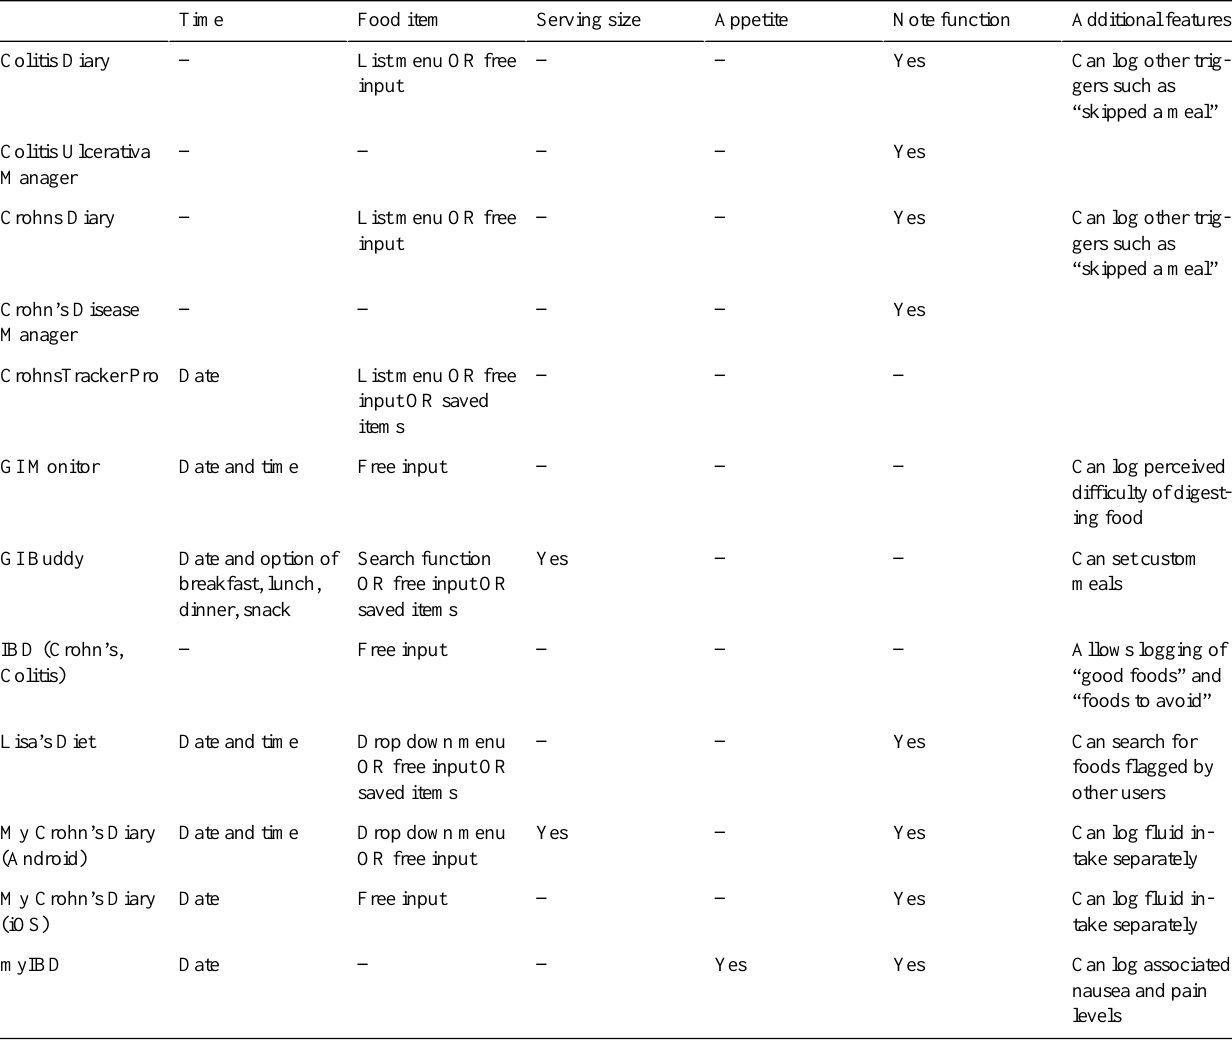
Table 7. Apps offering dietary tracking.